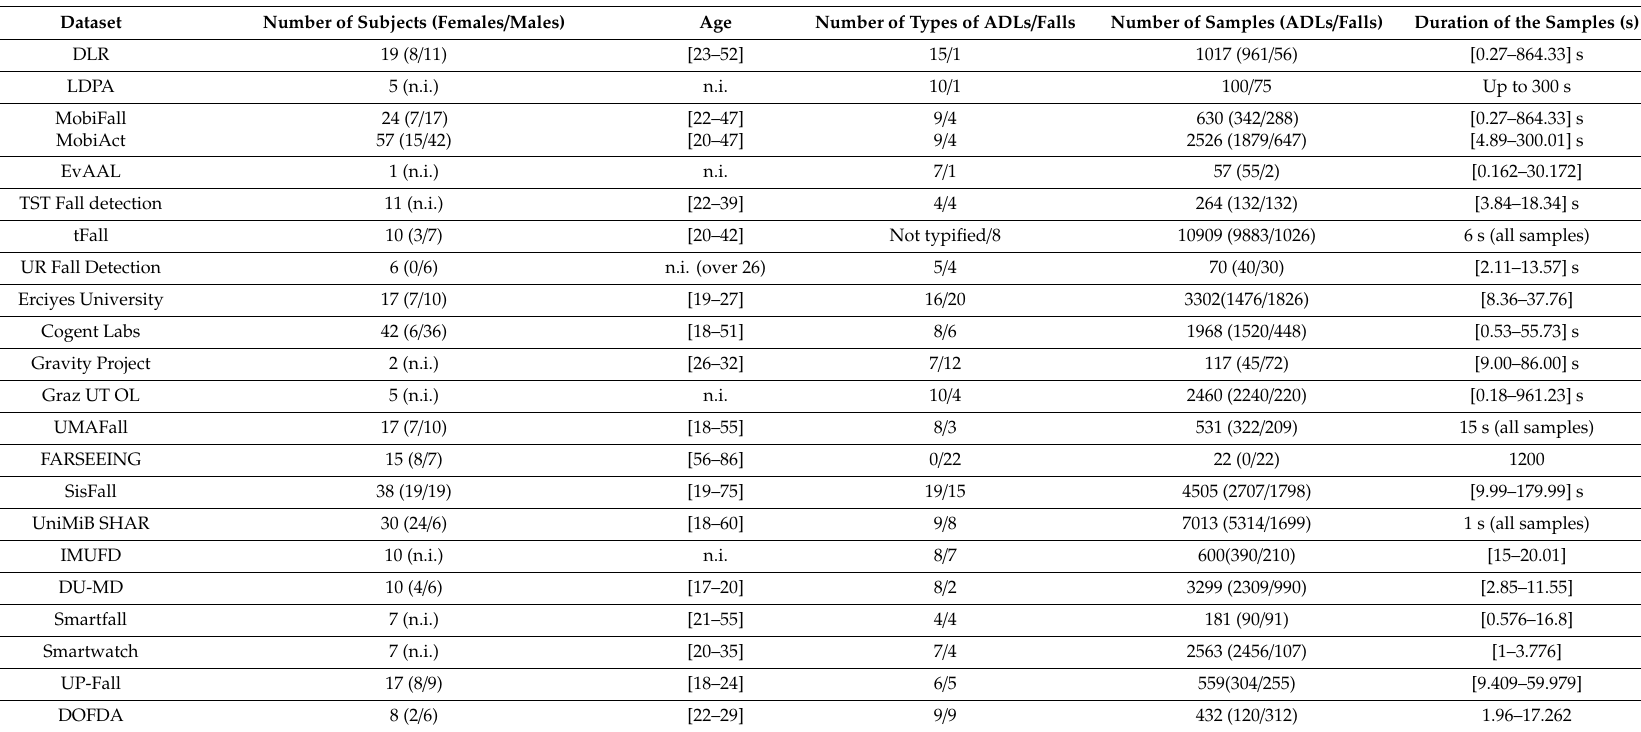
Table 2. Basic characteristics of the experimental subjects and the emulated movements for the di ff erent datasets (n.i.: not